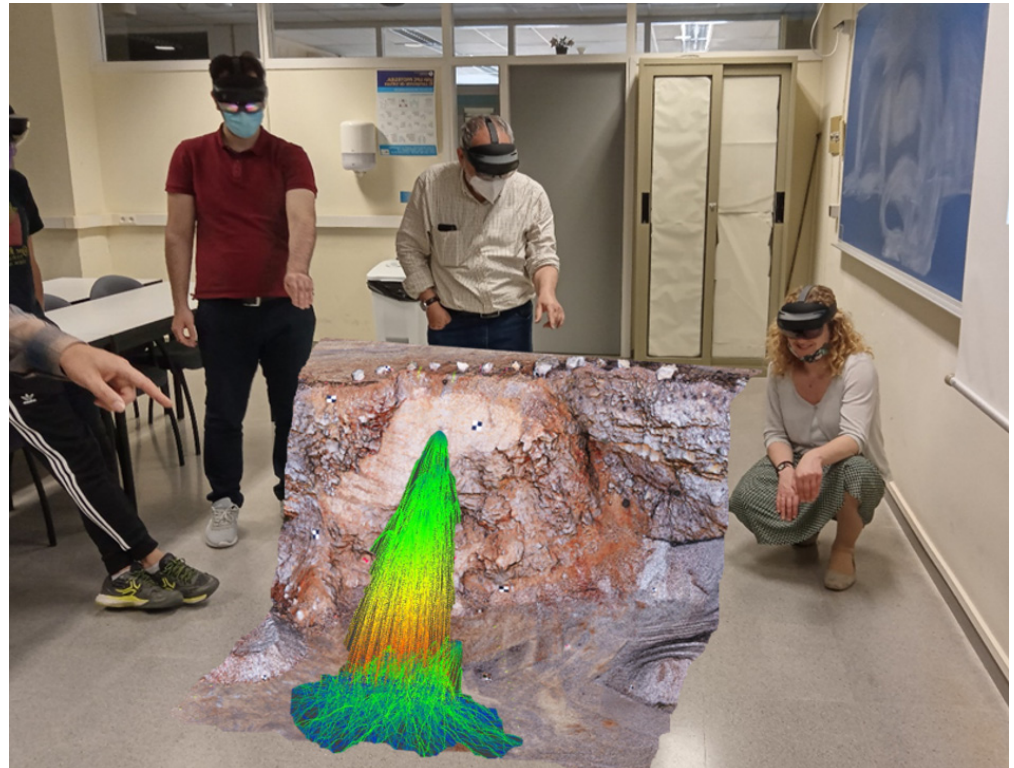
Figure 16. MR visualization concept of a limestone site used in the GeoRisk project to drop blocks, as shown in Figure 15. The 3D slope model (scale 1:20) was built by means of a drone flight. The result of the rockfall simulation with the RockGIS code [57] is presented over the slope (pictures courtesy of GeoRisk project).